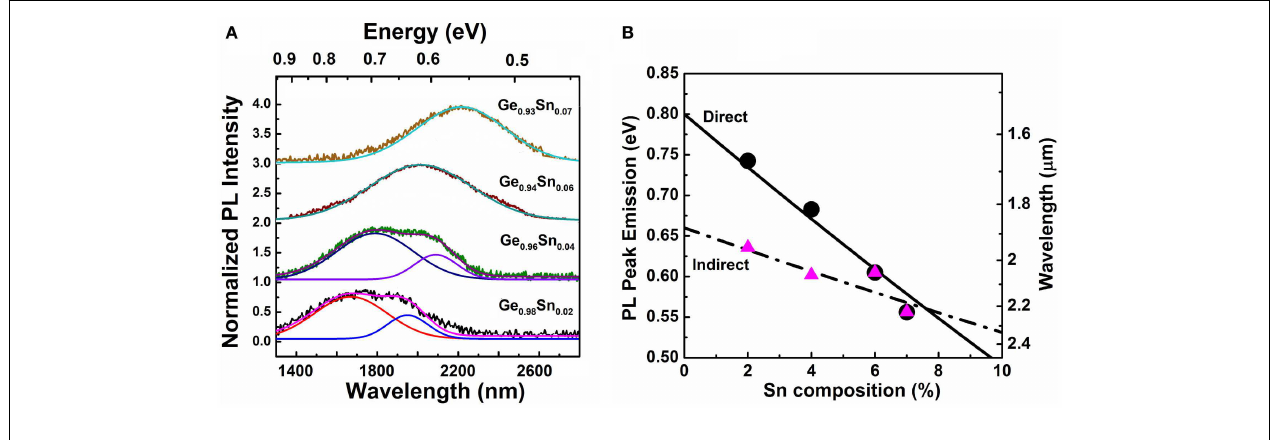
bowedVegard’s law interpolation for the direct (solid line) and indirect band-gap (dash line) of Ge 1 − x Sn x alloy is plotted for different Sn compositions and is overlaid with experimental data (solid